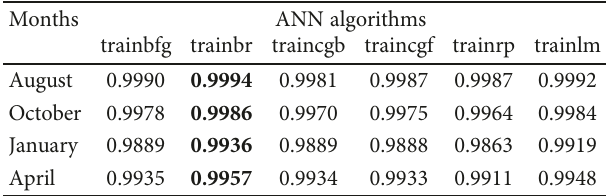
Table 2: ANN algorithm estimation results in Malatya.